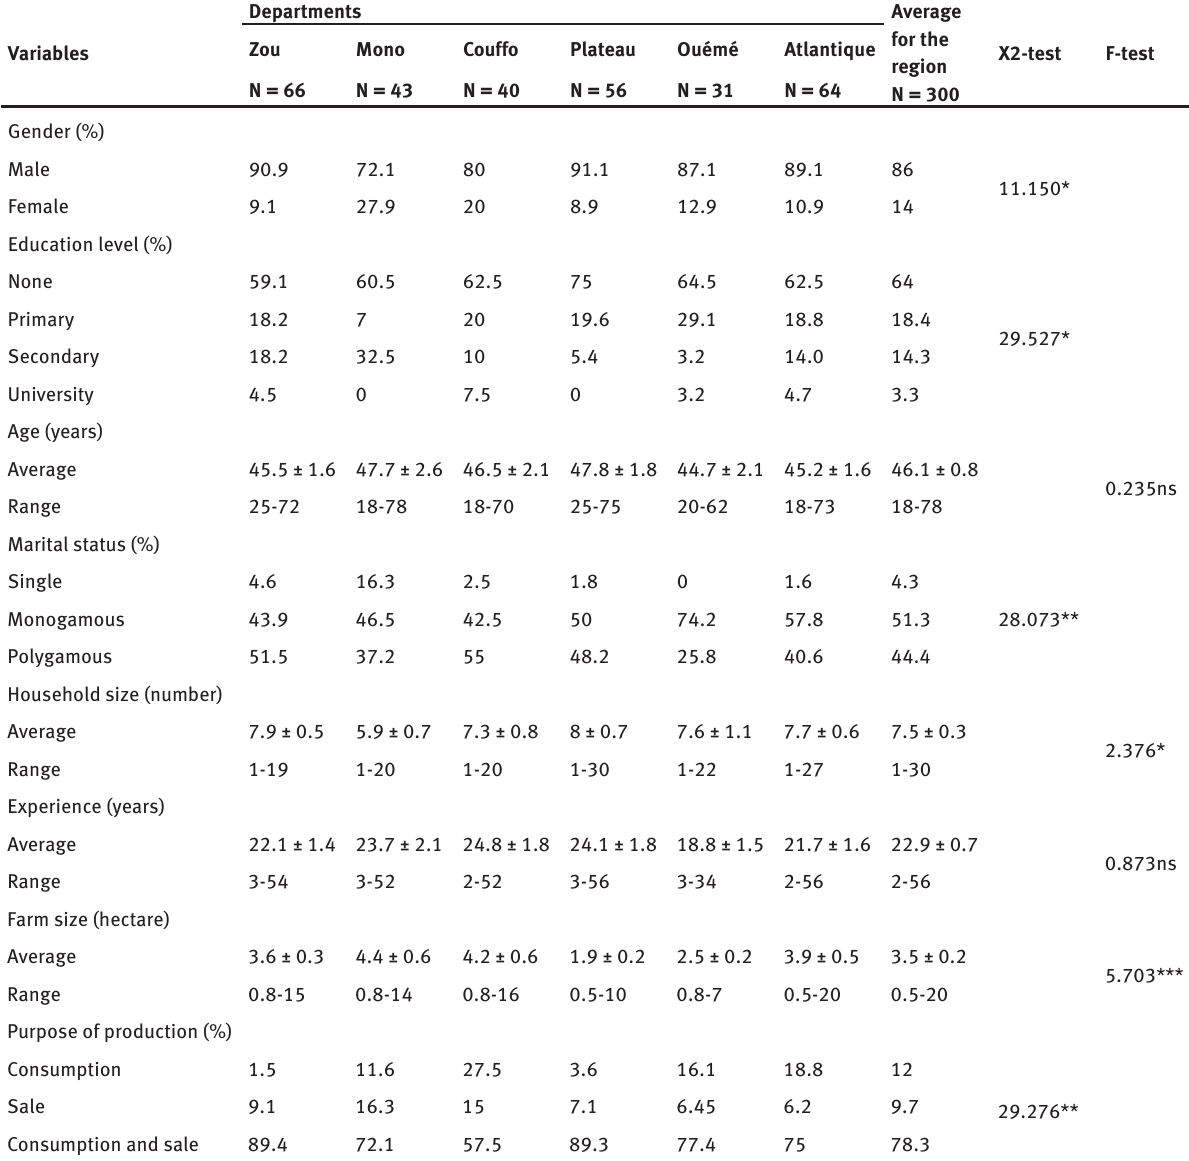
Table 2 : Socio-demographic and farm characteristics of the maize producers in the six-surveyed departments of the southern Benin